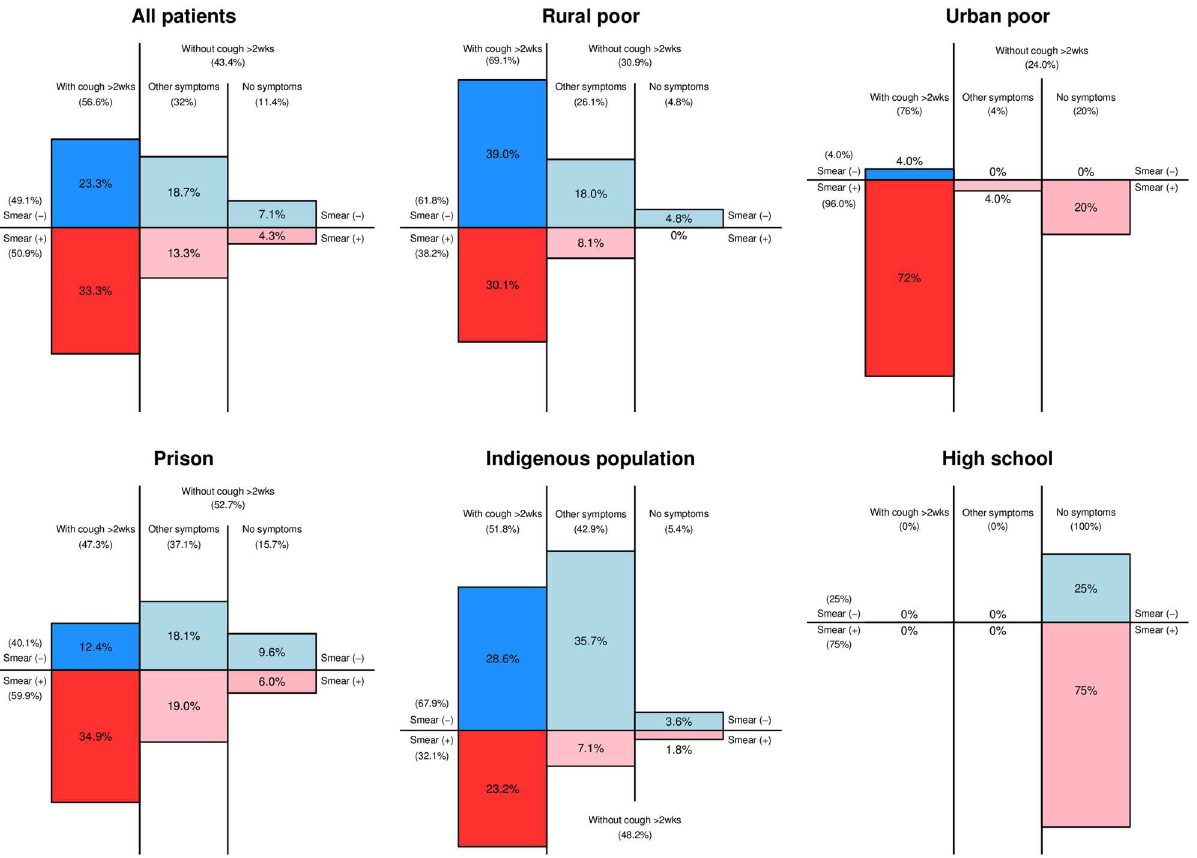
Fig 1. Composition of bacteriologically-confirmed TB patients by smearand symptom status, by target populations. Patients with unknownor missing sputum smear results were excludedfrom the calculation.